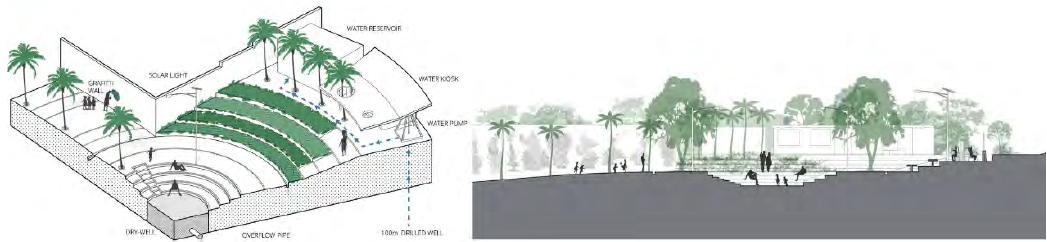
Figure 4. Cross-section and section in the main plaza of the project. Source: Archdaily,